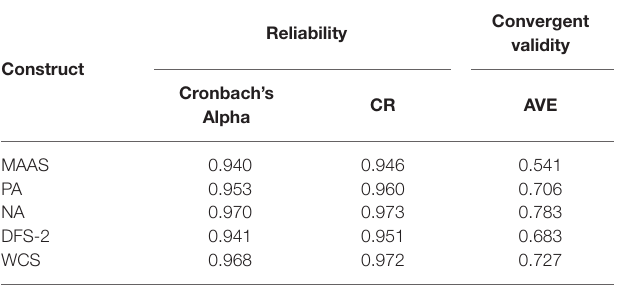
TABLE 4 | Reliability and Convergent validity of constructs.